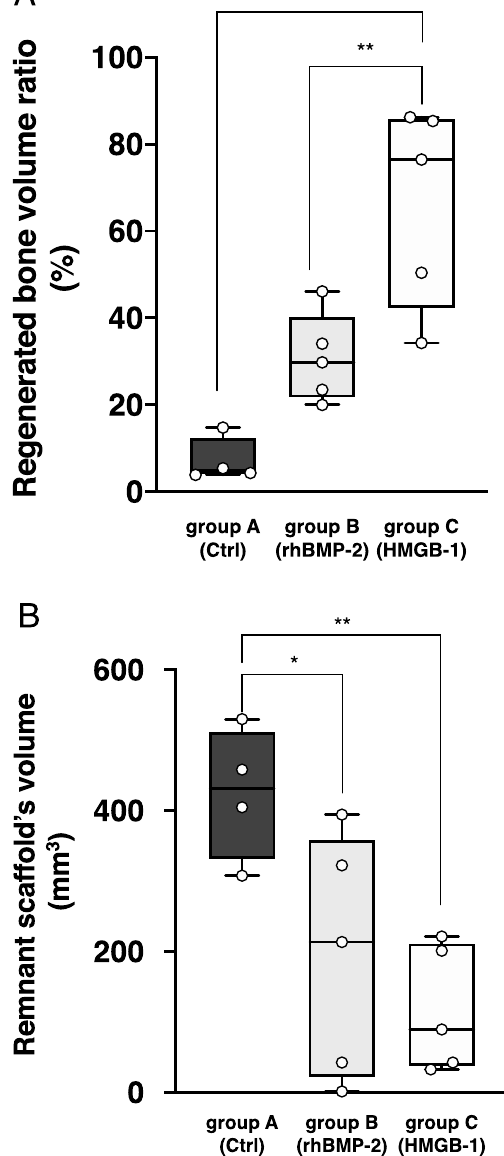
Figure 3. Comparison of the regenerated bone volume ratio and remnant scaffold volume among groups. The regenerated bone volume ratio among the three groups showed a negative correlation with the remnant scaffold’s volume. ( A ) The regenerated bone volume ratio in group C (HMGB-1) was significantly different from that in (control) and group B (rhBMP-2) ( p = 0.0004 and 0.0097, respectively). The ratio was the highest in group C, followed by group B (hrBMP-2) and group A (control). ( B ) The remnant scaffold volume in group C (HMGB-1) and group B (rhBMP-2) showed a significant difference compared to group A (control) ( p = 0.01 and 0.0481, respectively). The volume was highest in group A (control), followed by group B, and C. Statistical analysis was performed using one-way ANOVA, followed by the Tukey–Kramer post-hoc test; * p < 0.05; ** p < 0.01; *** p < 0.001. PRISM 8 software ver. 8.3.0 (https:// www. graph pad. com/ scien tific- softw are/ prism/) was used for the analysis and